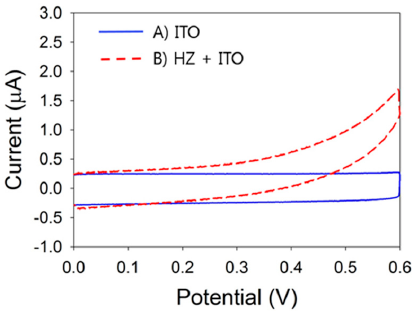
Figure 2. Cyclic voltammograms of (A) Tris buffer (pH 8) and (B) 1 mM·HZ in Tris buffer (pH 8) using an ITO electrode at a scan rate 50 mV/s.